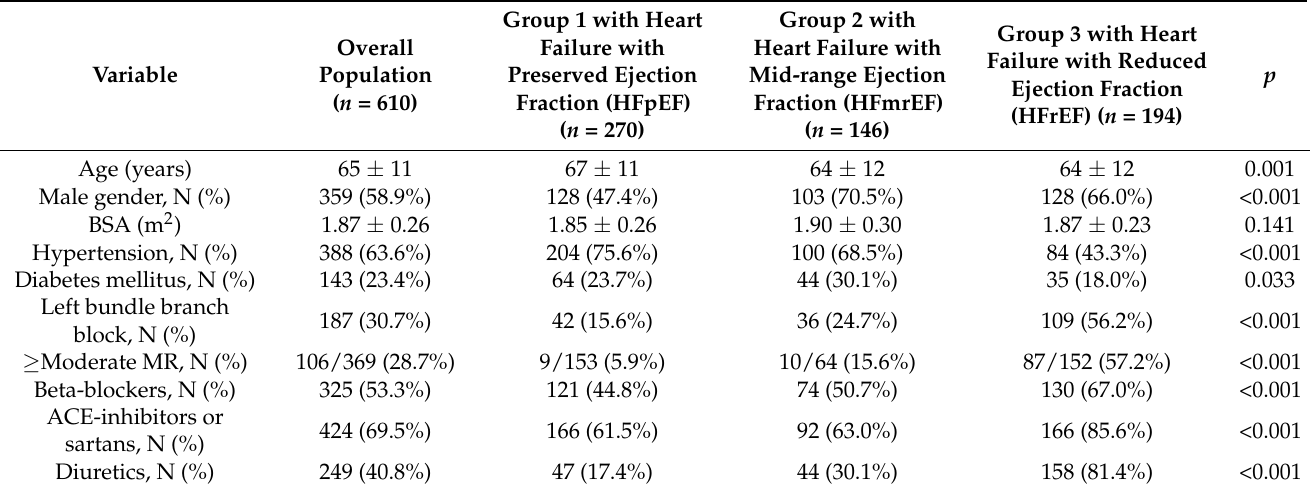
Table 1. Study population.